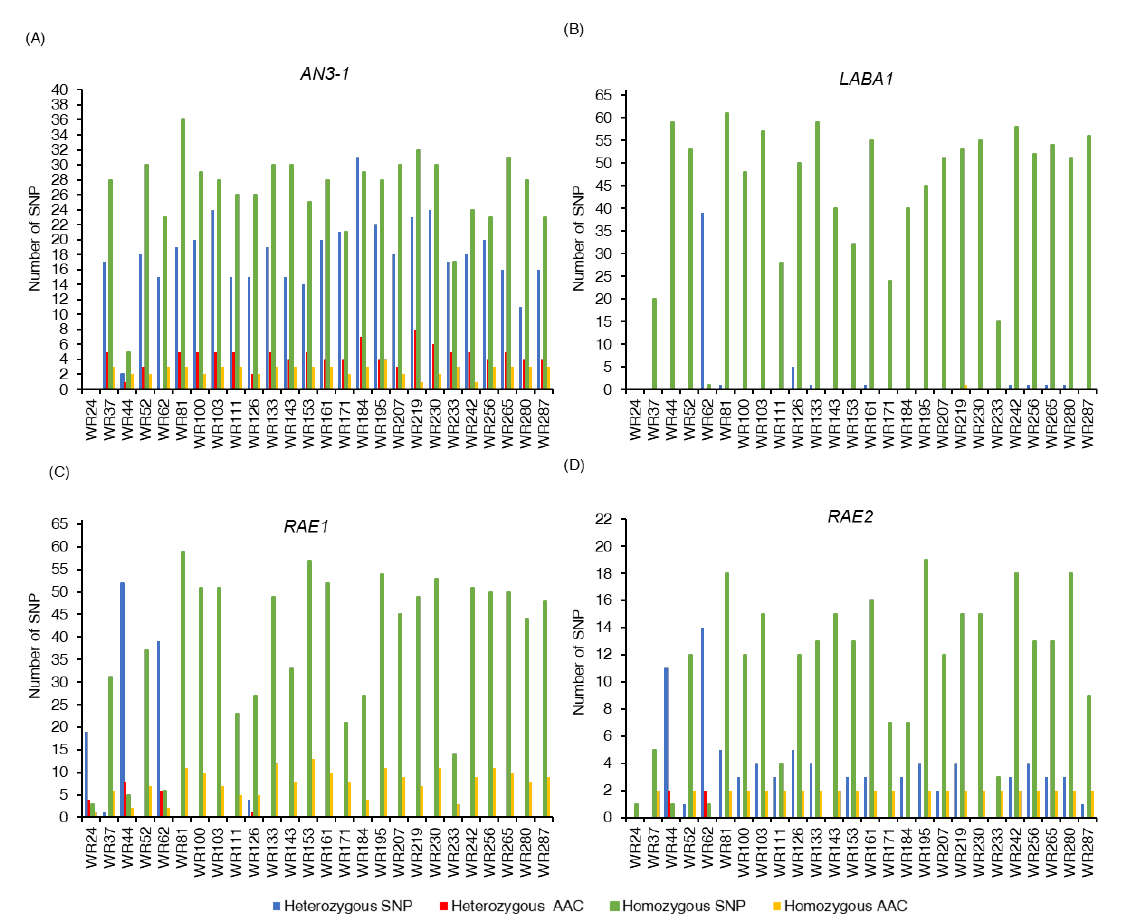
Figure 3. Variation of homozygous and heterozygous single nucleotide polymorphisms (SNPs) and corresponding amino acid changes (AAC) of four loci related to awn development in 26 Australian wild rice samples: ( A ) Total number of homozygous and heterozygous single nucleotide polymor- phisms (SNPs) and corresponding amino acid changes (AAC) of AN3-1 ( Awn3-1 ); ( B ) Total number of homozygous and heterozygous single nucleotide polymorphisms (SNPs) and corresponding amino acid changes (AAC) of LABA1 ( LONG AWN AND BARB 1 ); ( C ) Total number of homozygous and heterozygous single nucleotide polymorphisms (SNPs) and corresponding amino acid changes (AAC) of RAE1 ( REGULATION OF AWN ELONGATION 1 ); ( D ) Total number of homozygous and heterozygous single nucleotide polymorphisms (SNPs) and corresponding amino acid changes (AAC) of RAE2 ( REGULATION OF AWN ELONGATION 2 ).